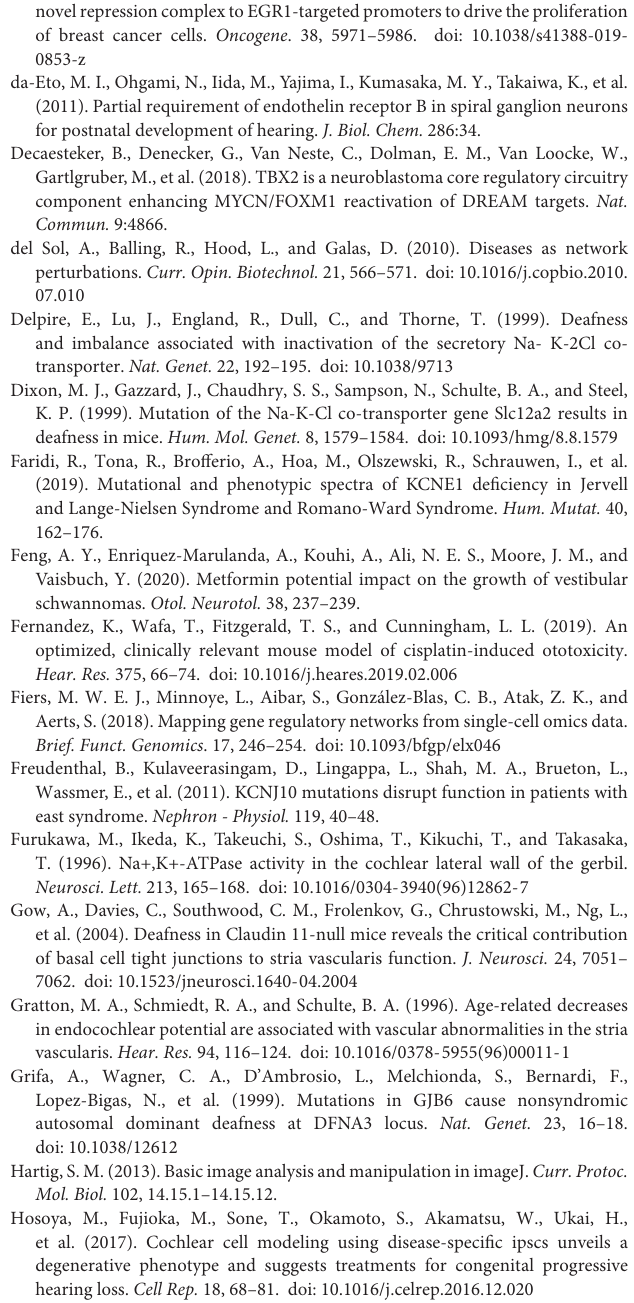
Supplementary Table 1 | Marker genes of UMAP clusters of the cisplatin-treated and control scRNA-Seq datasets as identified by the Seurat FindMarkers function. Supplementary Table 2 | Forward, reverse, and probe primer sequences for ddPCR